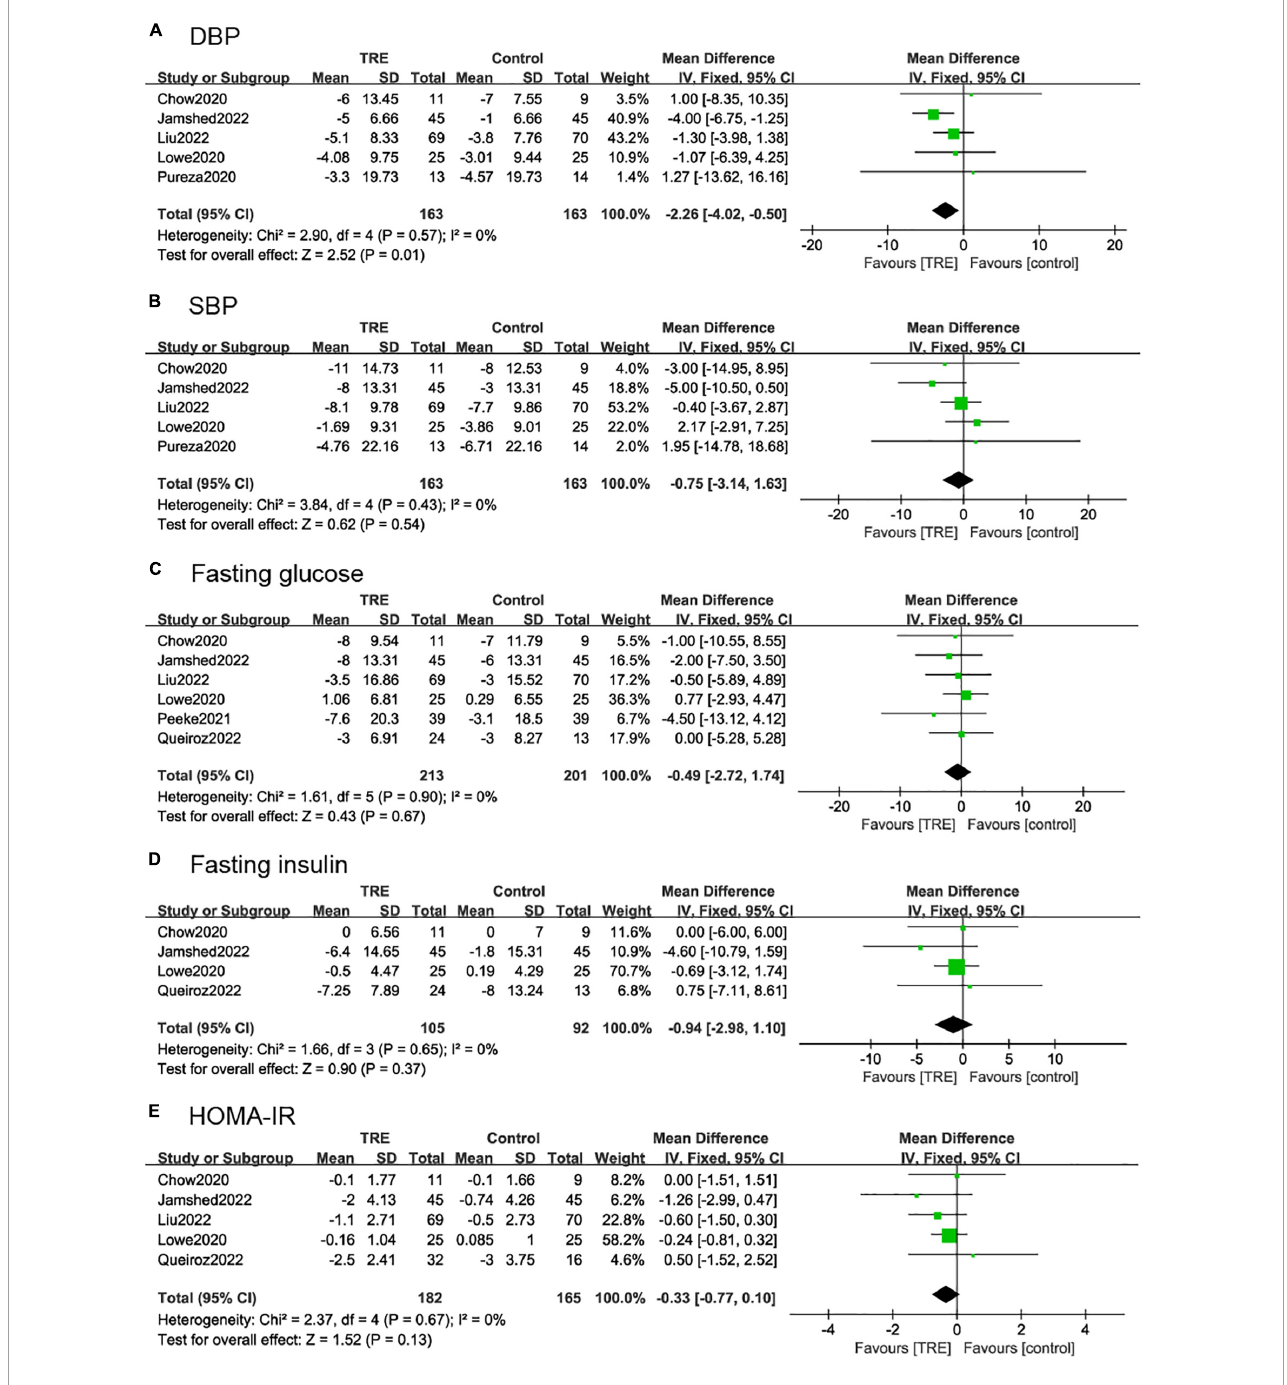
FIGURE5 Forest plots of comparisons between TRE and the control groups in (A) diastolic blood pressure (DBP), (B) systolic blood pressure (SBP), (C) fasting glucose, (D) fasting insulin, and (E) homeostasis model assessment-insulin resistance